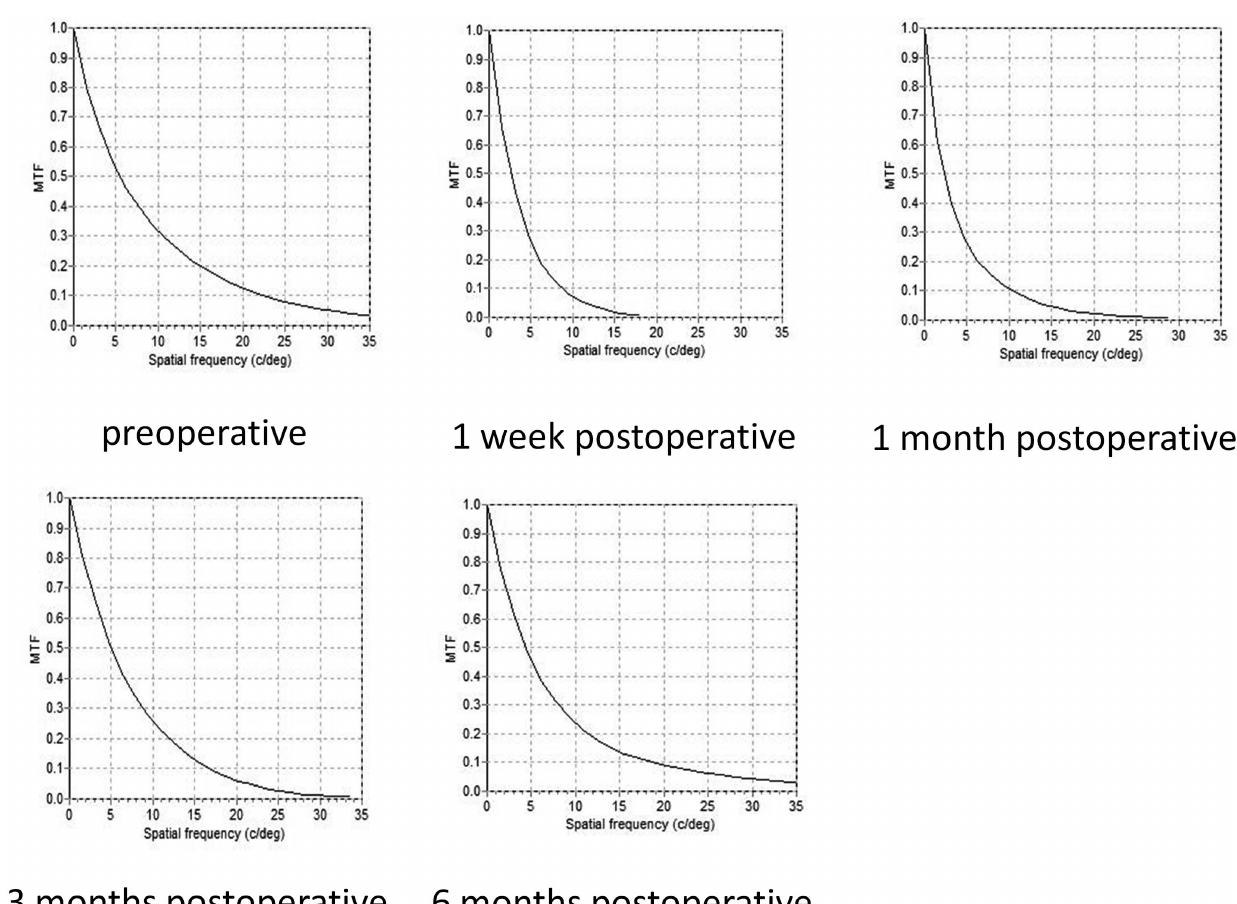
Figure 2. The representative modulation transfer function curves of eyes undergoing femtosecond lenticule extraction preoperatively, and 1 week and 1, 3 and 6 months postoperatively.